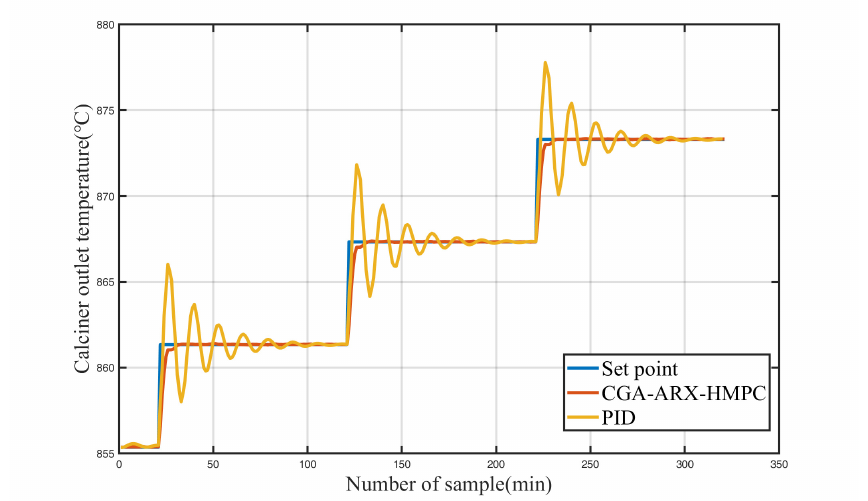
Figure 10. Comparison chart of dynamic processes.